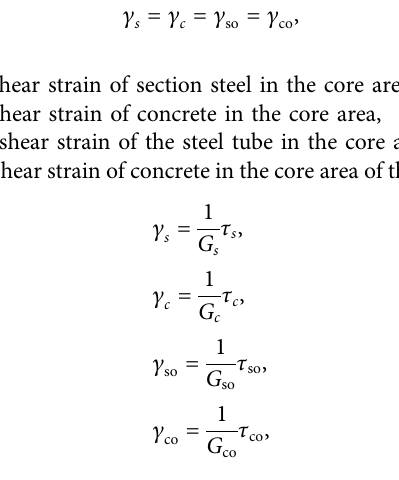
FIGURE 6 | Reinforcement of specimen JD-4.